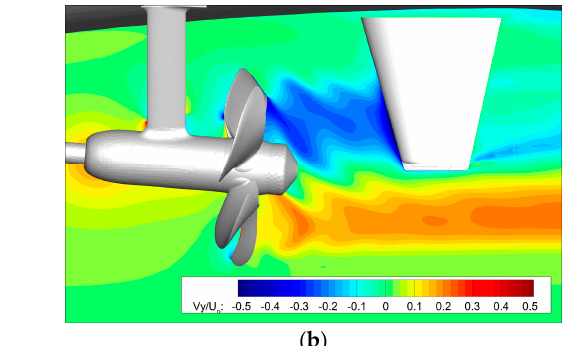
Figure 6. Measured and numerically predicted rudder forces and moment for the twin flat rudders: ( a ) lift force; ( b ) drag force; ( c ) moment.